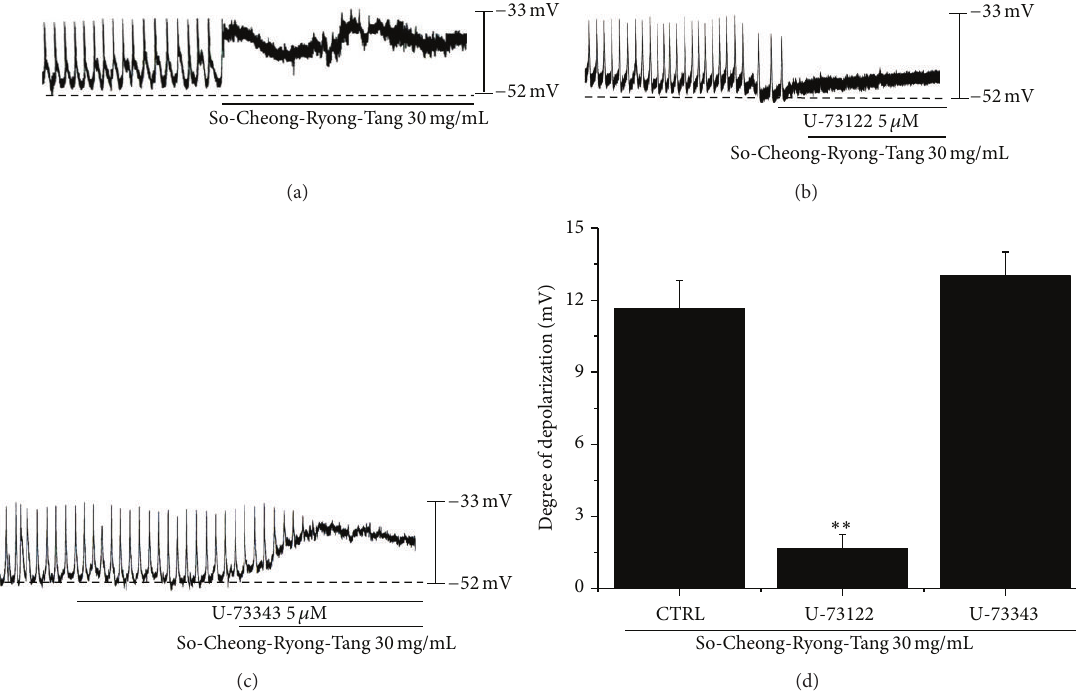
Figure 5: Effects of SCRT on phospholipase C inhibitors in cultured ICCs. (a) SCRT (30 mg/mL) induced membrane depolarizations on ICCs. (b) U-73122 (5 𝜇 M), a phospholipase C inhibitor, abolished the generation of pacemaker potentials. U-73122 blocked the SCRT-induced (30 mg/mL) membrane depolarizations. (c) The application of U-73343 (5 𝜇 M) did not show any influence on the generation of pacemaker currents.Also,U-73343didnotblocktheSCRT-induced(30 mg/mL)membranedepolarizations.(d)TheresponsestoSCRTinphospholipase C inhibitors are summarized in (d). Bars represent mean values ± SEs. ∗∗ 𝑃 < 0.01 . Significantly different from untreated controls. CTRL: